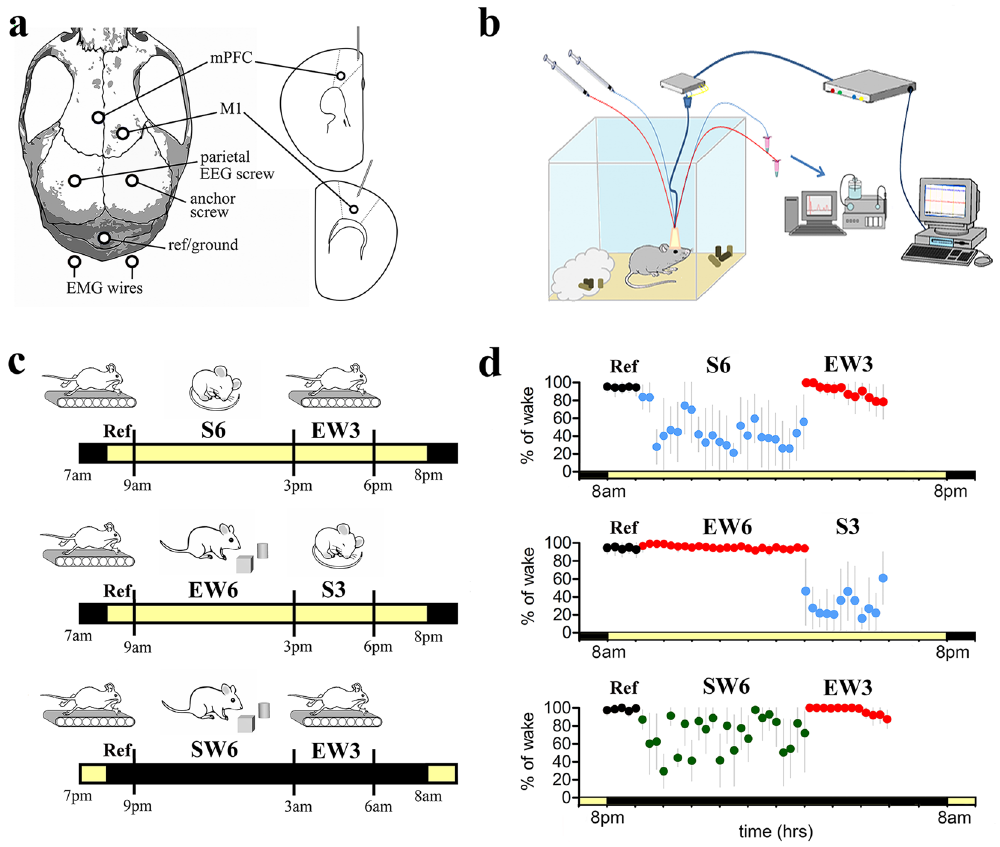
Figure 1. Experimental design. ( a ) Schematic diagram showing the placement of the microdialysis probes, EEG electrodes and EMG wires; ( b ) set-up for EEG recording and microdialysis; ( c ) the 3 experimental groups. ( d ) mean % of wakefulness for each group in 15-min intervals. The 5 time-points in black refer to the end of the first hour and the entire second hour spent by the mice on the treadmill and used as reference (Ref). Blue time points indicate the periods when mice had the opportunity to sleep. Time points in red indicate the period of enforced wakefulness using novel objects. Time points in green show when mice were either spontaneous awake at night or placed on the treadmill for the last 3 hours of the